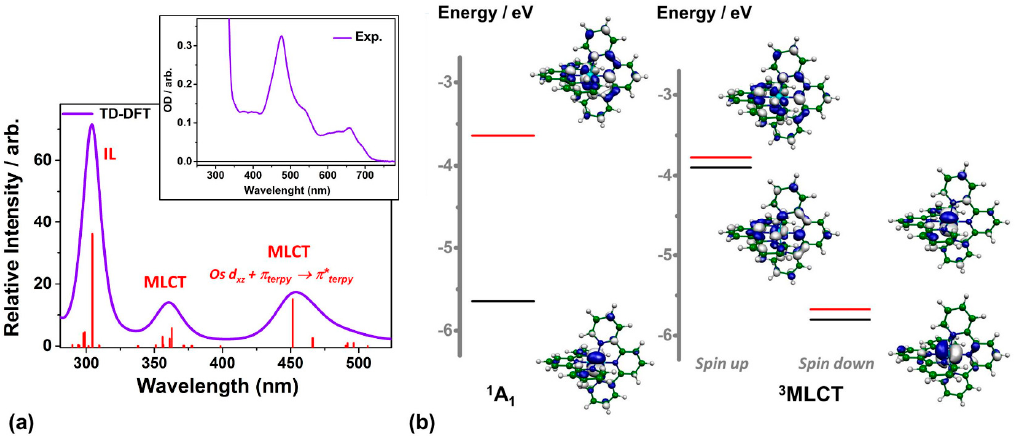
Figure 4. ( a ) Optical absorption spectrum simulated by TD-DFT. The main character of the transitions is indicated above the photo excited band. The experimental spectrum is shown in the inset; ( b ) The HOMO and LUMOS of the 1 A 1 and 3 MLCT states obtained from the DFT optimization.